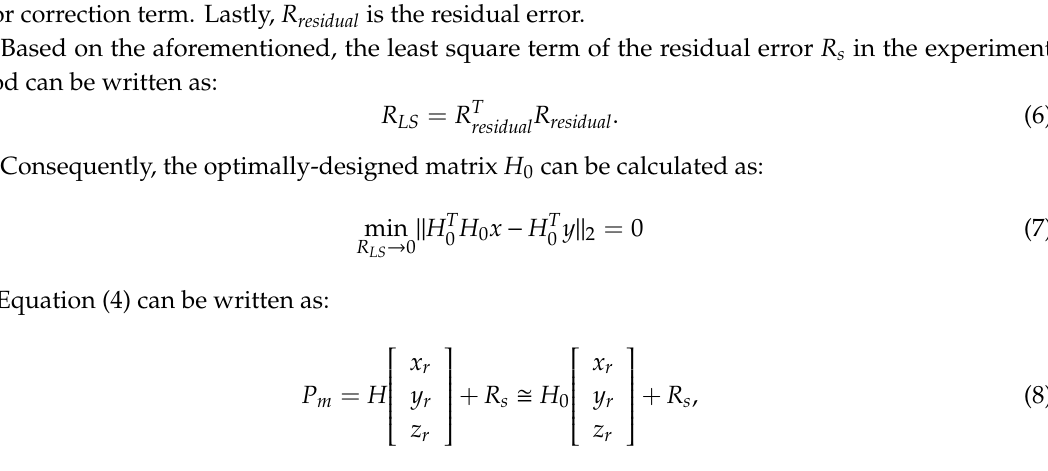
Figure 5. ( a ) GPS receiver geometry with a reference station; ( b ) flowchart of the GPS receiver bias estimation and removal by use of the Kalman filter.